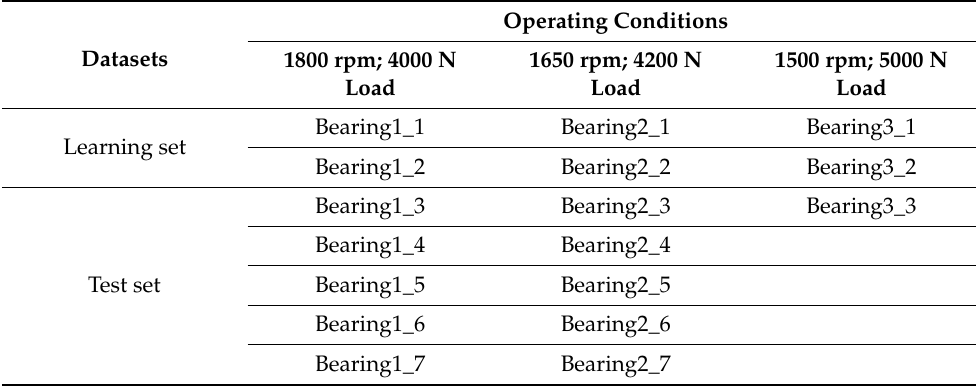
Table 3. Assignment of the different datasets to test and training